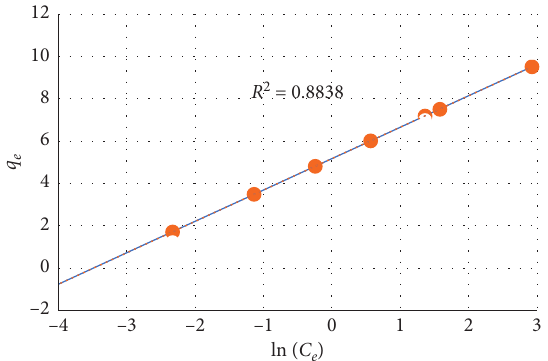
Figure 8: Temkin model for brilliant green dye onto AC.